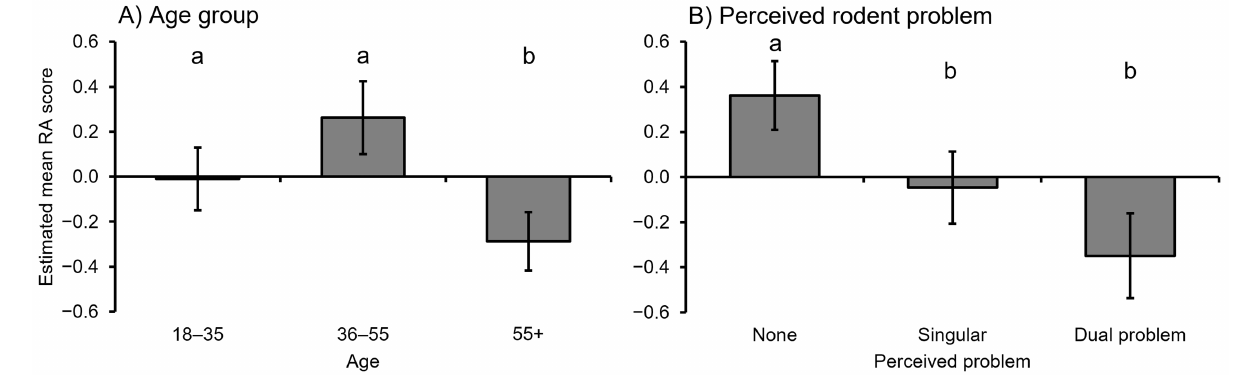
Figure 3. Estimated marginal mean rodent attitude (RA) scores of participants compared between ( A ) age groups and ( B ) perceived rodent problem. Negative values indicate negative attitudes, and values from 0 to positive reflect neutral/indifferent to positive attitudes. Error bars represent standard error of the mean. Differences in letters indicate significant differences based on post hoc analysis from best candidate model, p < 0.05 (Table 3).